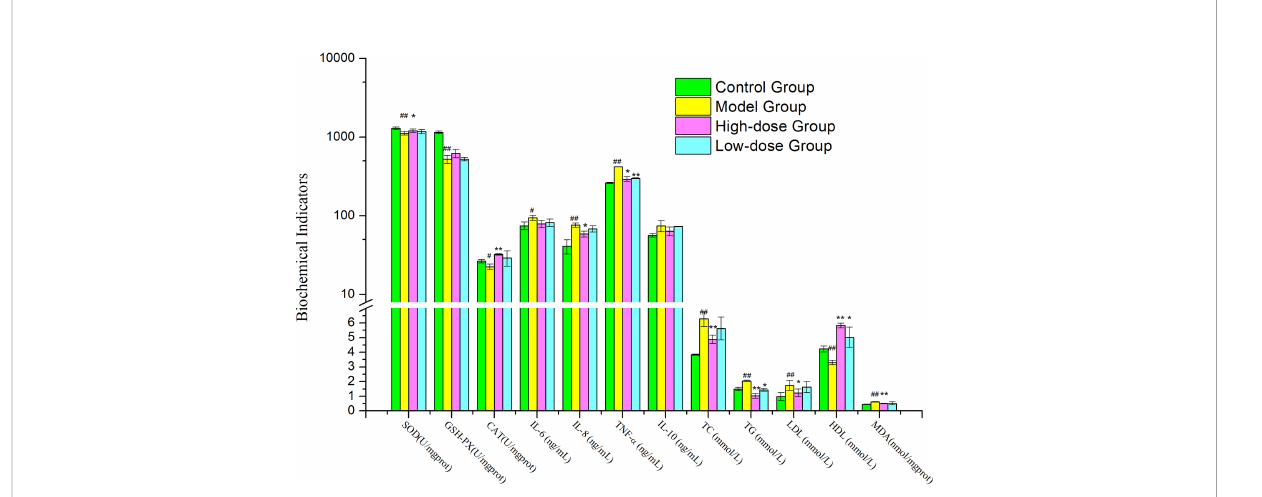
FIGURE 2 Effects of EMZAP on hepatic antioxidant capacity and serum biochemical indicators in mice (n = 10) * P < 0.05 and ** P < 0.01 vs Model Group, # P < 0.05 and ## P < 0.01 vs Control